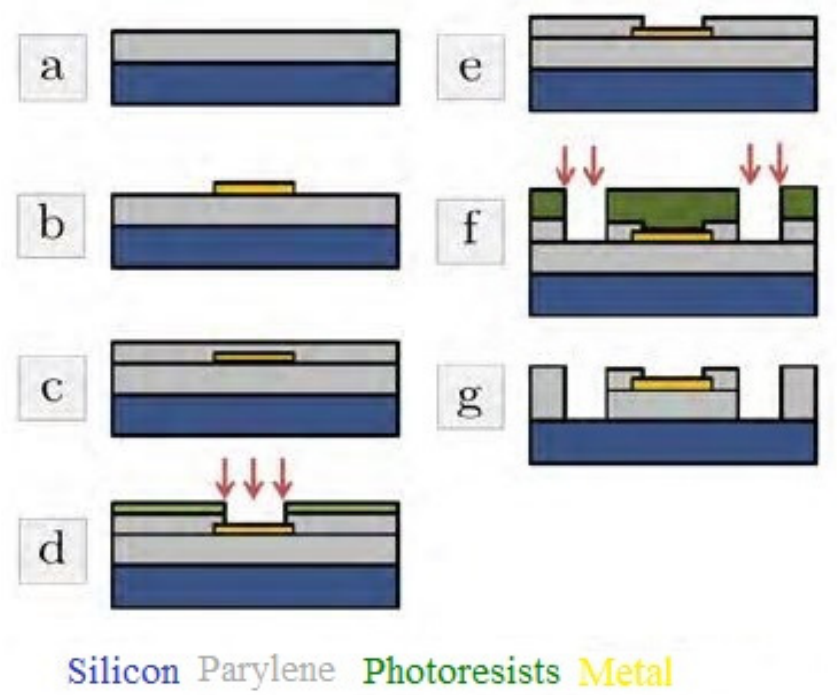
Figure 7. Schematic diagram of the fabrication process of the Parylene C/PEDOT-based neural sensors. ( a ) The deposition and annealing processes of Parlyene ( b ) Metallization and lift-off processes of the metallic layers were carried out. ( c ) Passivation process with Parylene C and annealing. ( d ) Passivation plasma etching process was carried out for electrode opening. Other processes like ( e – g ) plasma etching and photoresist stripping